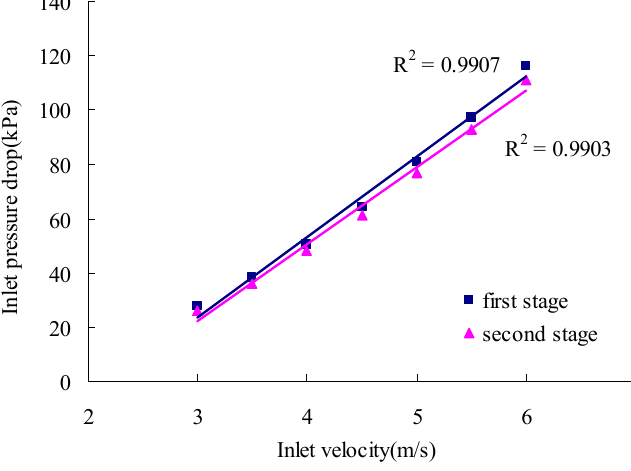
Figure 4. Relationship between pressure drop and inlet velocity.